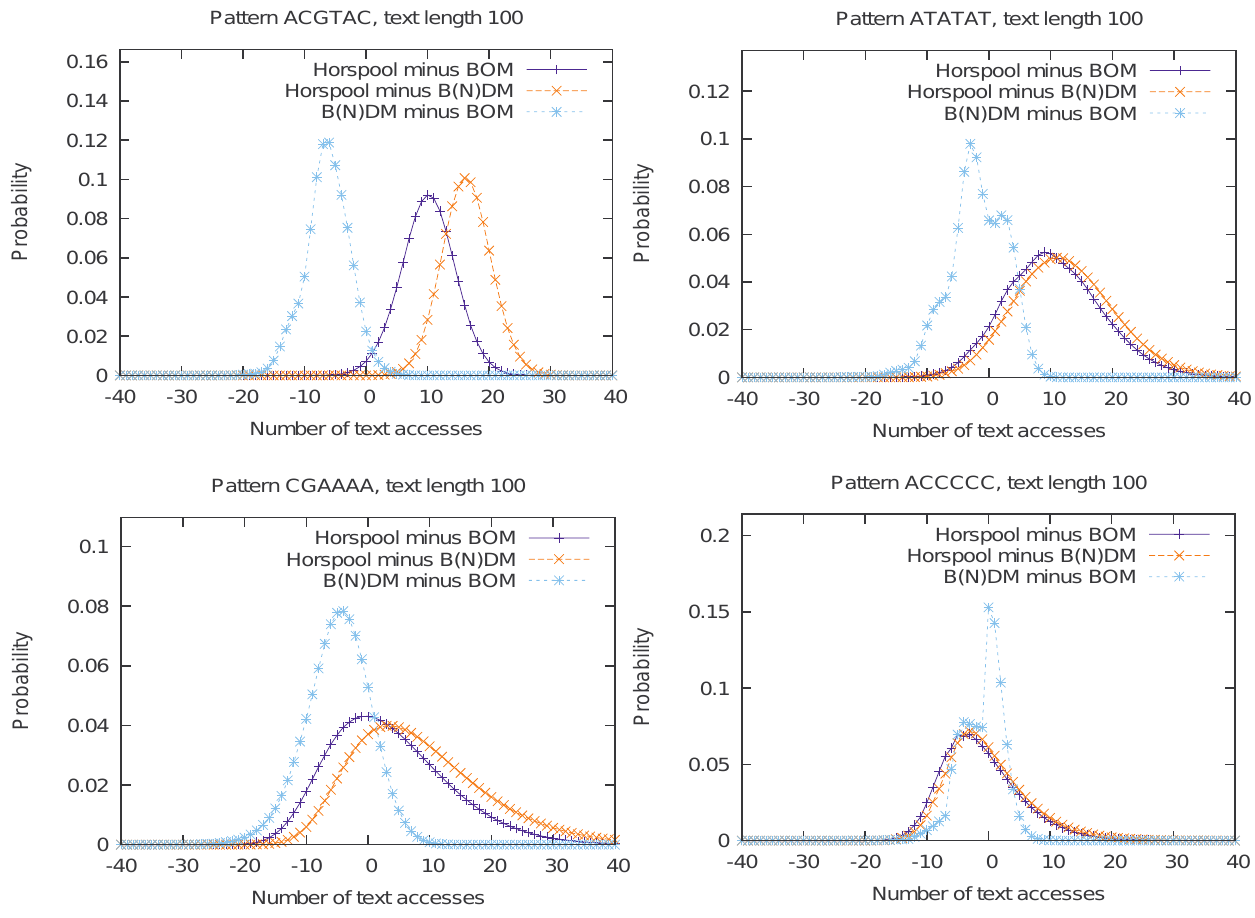
Figure 4. Exact distributions of differences in character access counts for different patterns using a second order Markovian text model estimated from the human genome and random texts of lengths